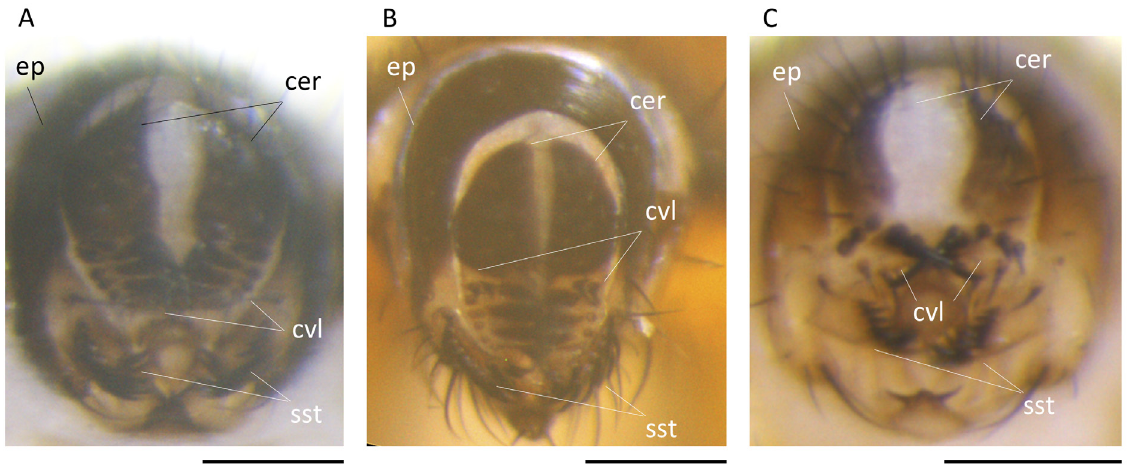
Fig. 3. Photomicrographs of male periphallic organs. A . D. seguyi Smart, 1945 (MNHN). B . D. aff. tsacasi Bock & Wheeler, 1972 (MNHN). C . D. mylenae David & Yassin sp. nov. (MNHN). Scale bars = 0.1